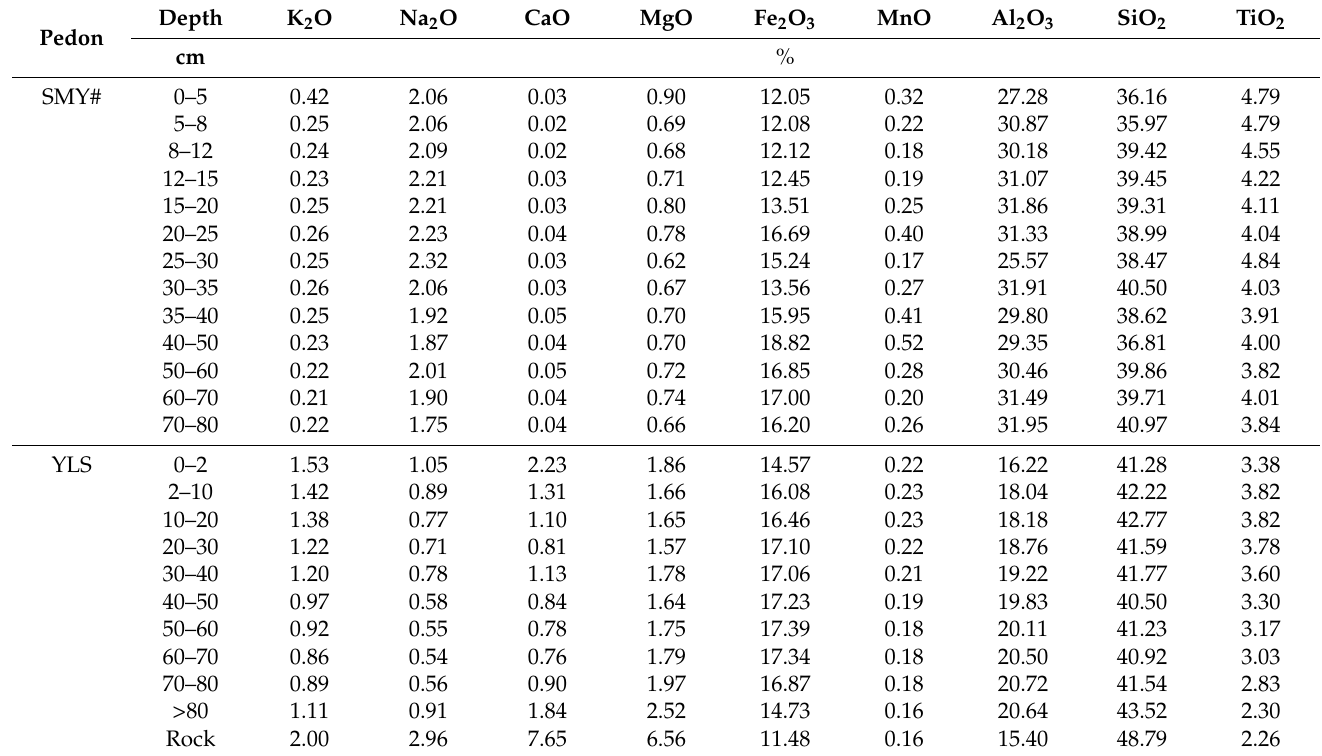
Table 2. Chemical and elemental concentrations of the late Miocene sediments in the SMY and YLS